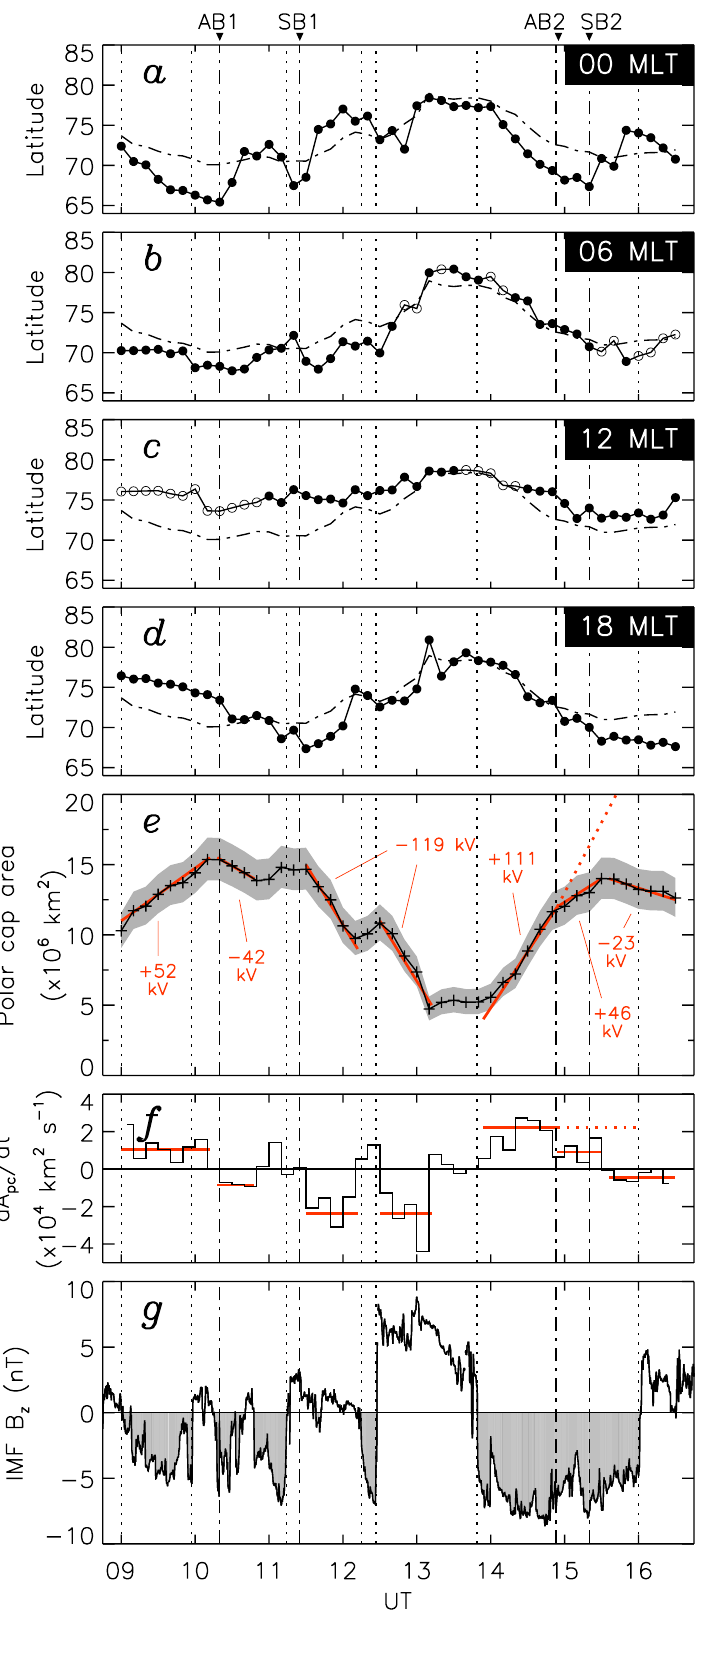
Fig. 6. (a–d) Time series of the OCB latitude along the noon and midnight, dawn and dusk meridians. The latitude of the equivalent circular OCB (ECB) is indicated by a dot-dashed curve. (e) The area of the polar cap deduced from the OCB estimates (crosses), the grey area indicating the uncertainty based on assuming our OCB estimate is incorrect by ± 1 ◦ at all local times. Superimposed in red are lines approximating the vari- ation in polar cap area. The numbers are estimates of 8 day − 8 night . (f) The rate of change of area of the polar cap. Red lines indicate the gradients of the fits shown in panel (e). (g) The IMF B z component, time-lagged to the mag- netopause. In all panels, vertical dot- ted lines indicate the times of transitions in IMF B z and vertical dot-dashed lines indicate the onsets of substorm breakup and auroral